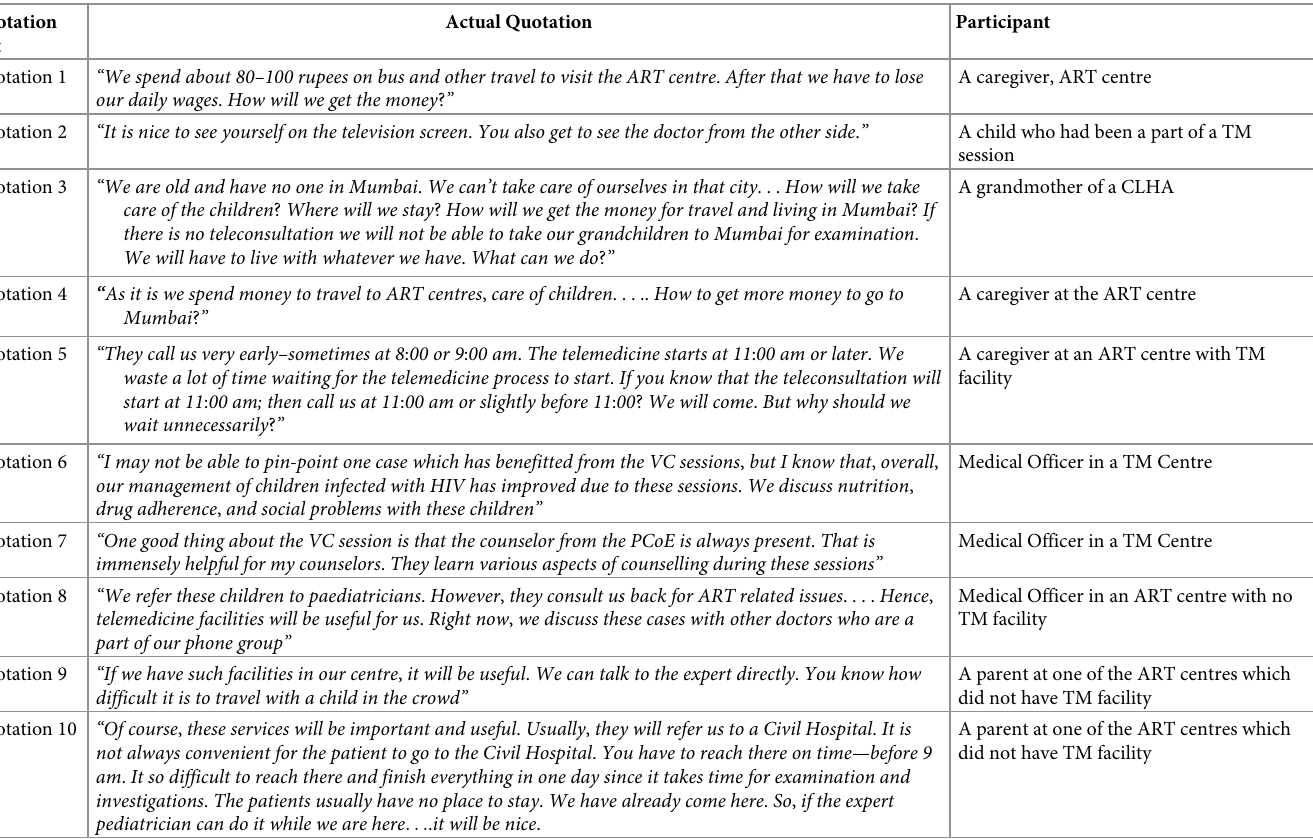
Table 1. Table of quotations from the qualitative study on the use of telemedicine (TM) for children living with HIV/AIDS (CLHA), Maharashtra,